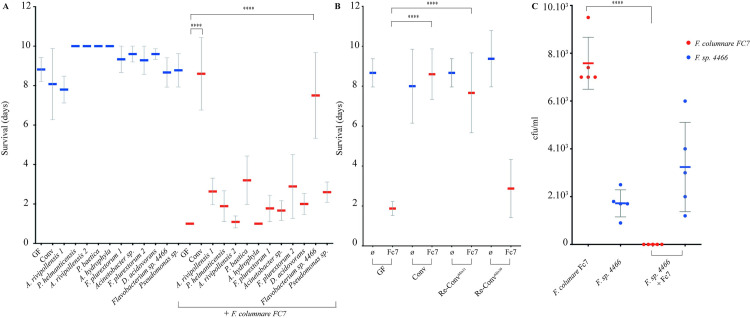
Protection of GF trout larvae against F. columnare infection by individual species isolated from the Conv rainbow trout microbiota.A: The 11 species isolated from Conv fish microbiota (Table 1) were added individually to rainbow trout larvae at 22 dph, followed by F. columnare Fc7 infection at 24 dph. From the 11 different strains, only Flavobacterium sp. strain 4466 protected re-conventionalized larvae from infection. B: Mix11, Mix10 (mix of all identified strain with the exception of Flavobacterium sp. strain 4466), were added to rainbow trout larvae at 22 dph, followed by F. columnare infection at 24 dph. Mix11 protected re-conventionalized larvae from infection, whereas Mix10 did not. For each condition n = 10 larvae. All surviving fish were euthanized at day 10 after infection. C: CFU/mL recovered from dissected intestines from GF fish exposed to F. columnare Fc7, Flavobacterium sp. strain 4466 or both, 24 hours post-infection. (****p<0.0001).